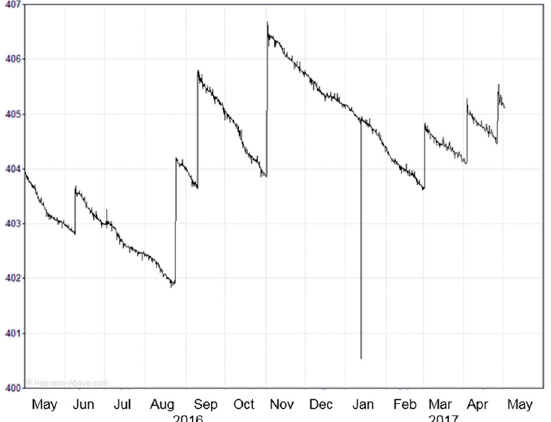
Figure 7. Evolution of the ISS orbital height during one year: periodic impulses to increase ISSS height, and gradual fall between them are clearly visible. Gradual fall is caused by the atmospheric drag.